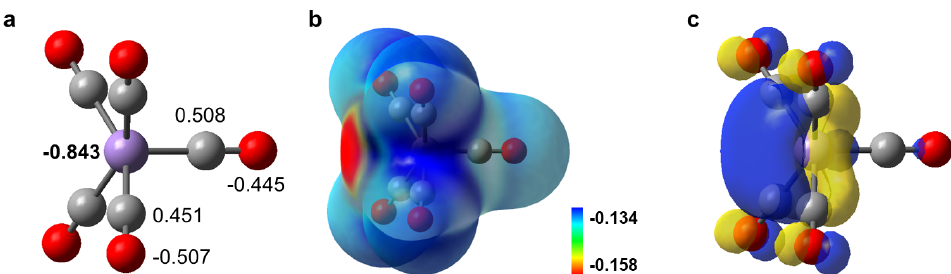
Figure 1. Calculated ( a ) structure and Mulliken charge, ( b ) electrostatic potential map in e/Bohr 3 , and ( c ) HOMO of Mn(CO) 5 − anion. The M06-2X/aug-cc-pVTZ level of theory is used [23–26]. Color code: C, grey; O, red; Mn, purple.